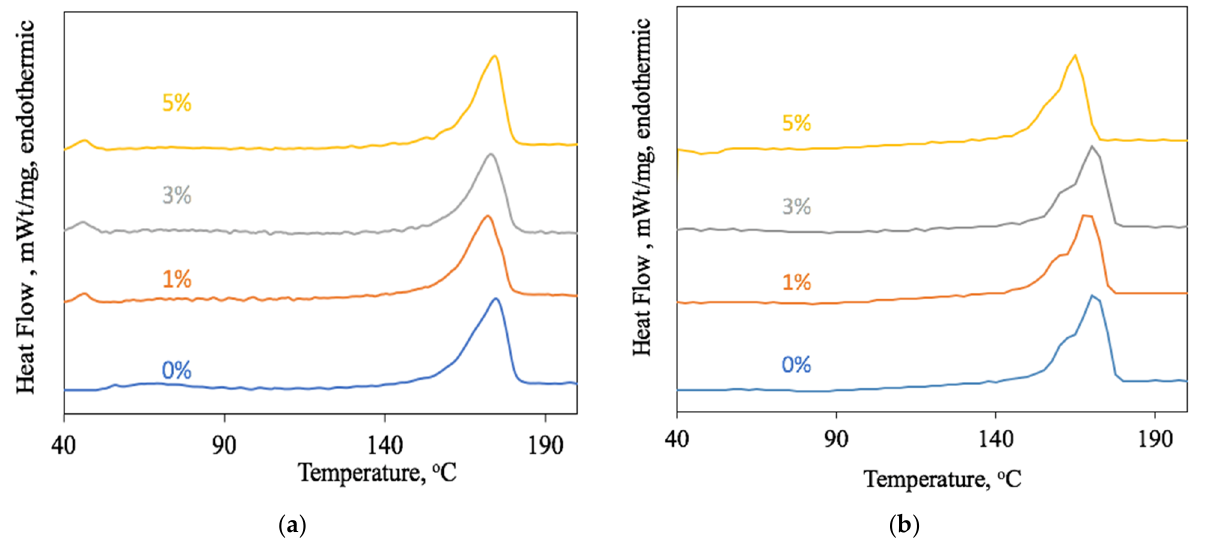
Figure 7. The PHB melting peaks with different hemin content: first heating ( a ) and second heating ( b ).